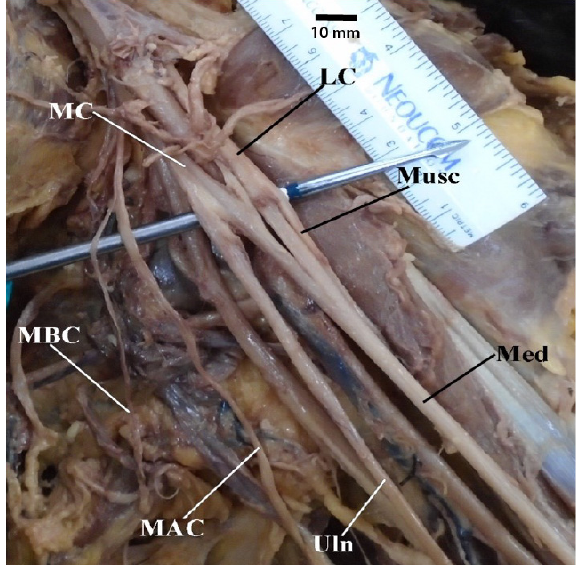
Figure 6. Photograph showing a common trunk of medial brachial cutaneous nerve and medial antebrachial cutaneous nerve. Abbreviations: LC = lateral cord; MAC = medial antebrachial cutaneous nerve; MBC = medial brachial cutaneous nerve; MC = medial cord; Med = median nerve; Musc = musculocutaneous nerve; Uln = ulnar nerve.